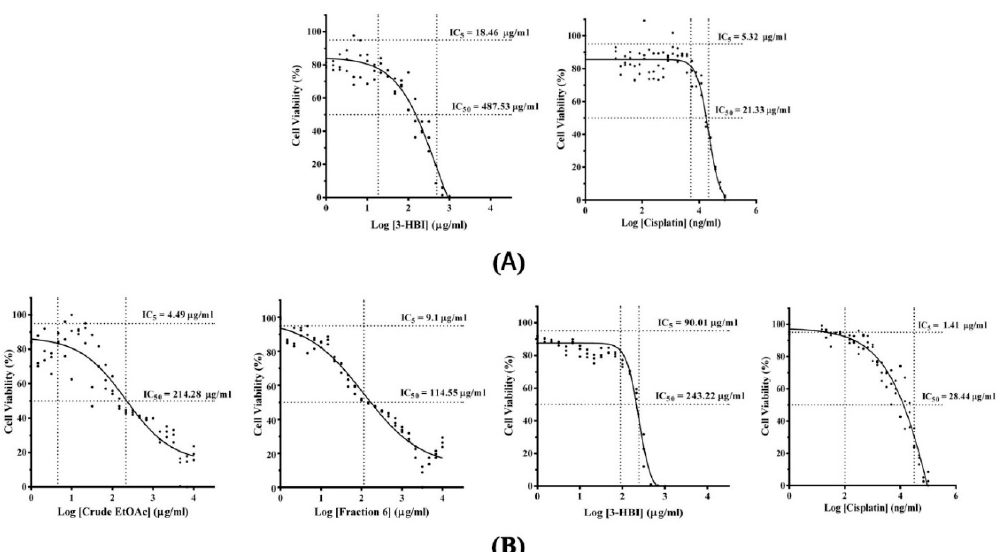
Figure 2. Investigation of the effect of MO crude extracts, fraction no. 6, 3-HBI and cisplatin on cell viability of MDMs and SCC15 cell lines. MTT assay was performed after cell treatment for 24 h. ( A ) IC 5 and IC 50 results of MDMs after treatment with different concentrations of crude extract, fraction no. 6, 3-HBI and cisplatin. ( B ) IC 50 results for antiproliferative effect of crude extract, fraction no.6,